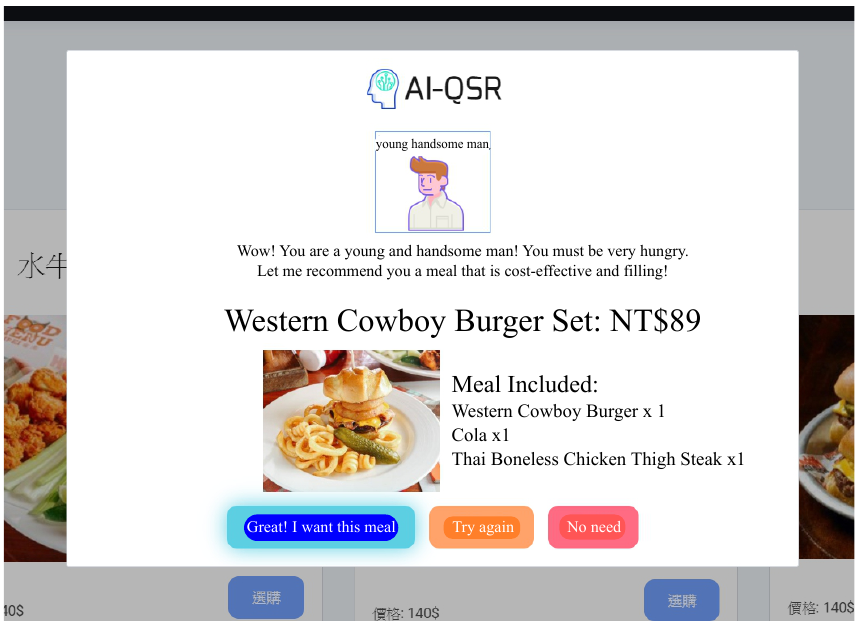
Figure 13. The UI of the popup-triggered recommendation.